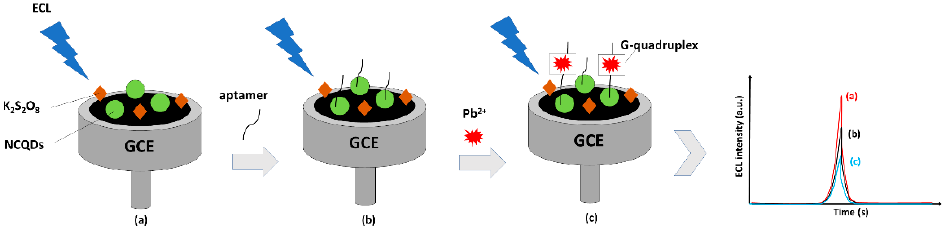
Figure 7. Surface functionalization of ( a ) GCE/NCQDs, ( b ) GCE/NCQDs/aptamer, and ( c ) GCE/NCQDs/aptamer/Pb 2+ .